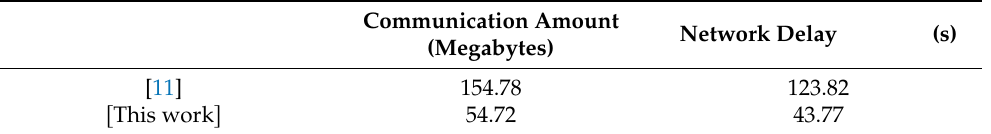
Table 7. Communication amount and network delay of our P k NC and the existing P k NC [11] in 10 Mbps